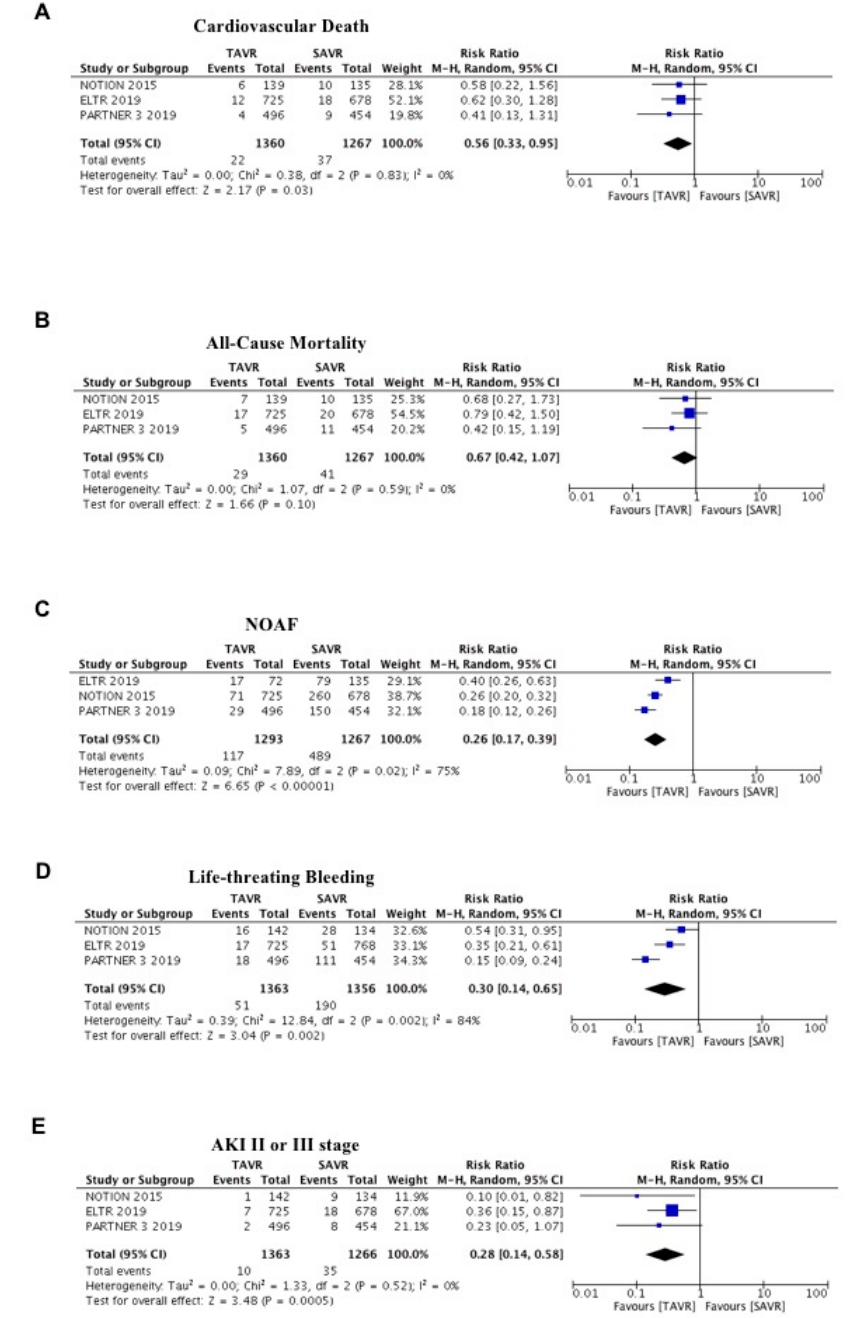
Figure 2. Meta-analysis of cardiovascular death, all-cause mortality, new-onset atrial fibrillation, life-threating bleeding, acute kidney injury II or III stage. ( A ) Forest plot and summary e ff ect of the di ff erence in the incidence of cardiovascular death, showing a significantly lower incidence in the TAVR arm ( p = 0.03). ( B ) Forest plot and summary e ff ect of the di ff erence in the incidence of all-cause mortality showing no di ff erence between transcatheter aortic valve replacement (TAVR) and surgical aortic valve replacement (SAVR; p = 0.10). ( C ) Forest plot and summary e ff ect of the di ff erence in the incidence of new-onset atrial fibrillation, showing a significantly lower incidence in the TAVR arm ( p < 0.001). ( D ) Forest plot and summary e ff ect of the di ff erence in the incidence of life-threating bleeding, showing a significantly lower incidence in the TAVR arm ( p < 0.002). ( E ) Forest plot and summary e ff ect of the di ff erence in the incidence of acute kidney injury II or III stage, showing a significantly lower incidence in the TAVR arm ( p <